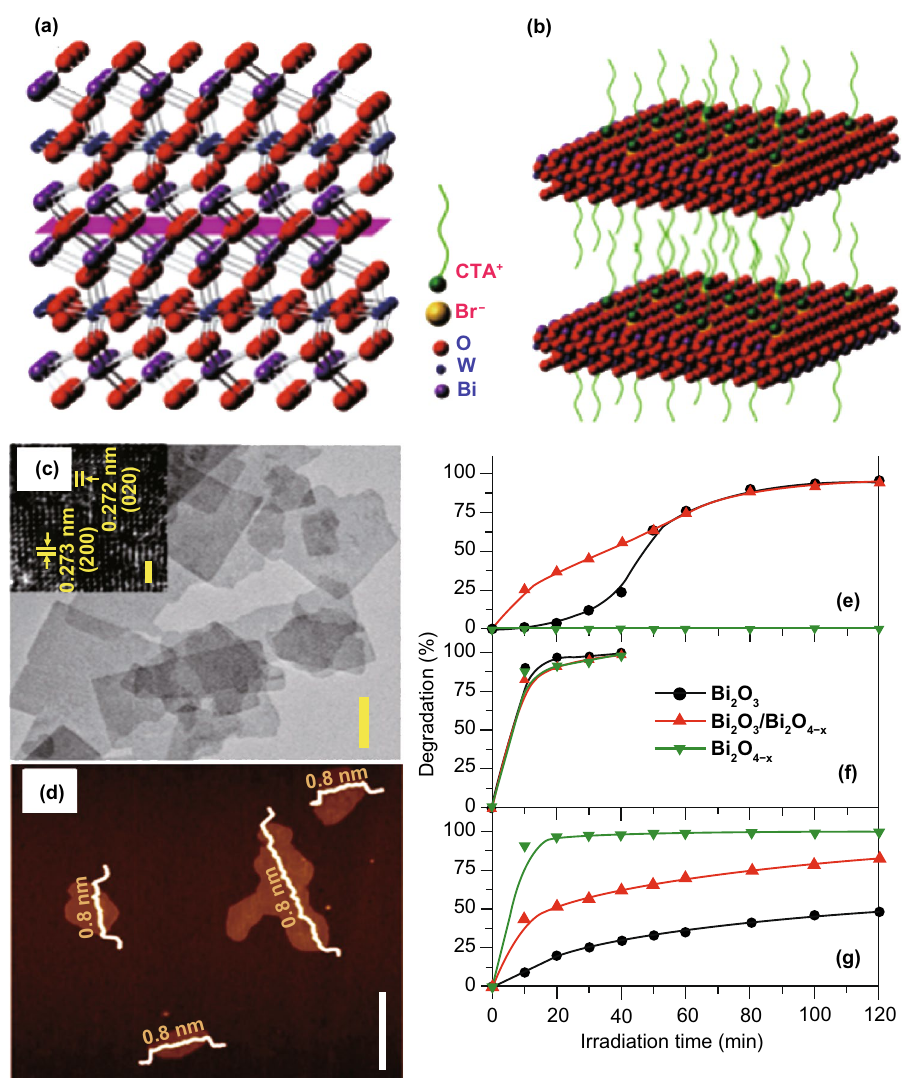
Fig. 6 a Bi 2 WO 6 crystal structure. b Fabrication method of the SL Bi 2 WO 6 with CTAB support. c TEM/HR‑TEM of Bi 2 WO 6 formed by CTAB support. d AFM analysis of SL Bi 2 WO 6 based on CTAB. Adapted with permission from Ref. [32]. Comparison of photo‑catalytic degradation of e MB, f MO, and g phenol over Bi 2 O 3 , Bi 2 O 3 /Bi 2 O 4− x , and Bi 2 O 4− x . Adapted with permission from Ref.